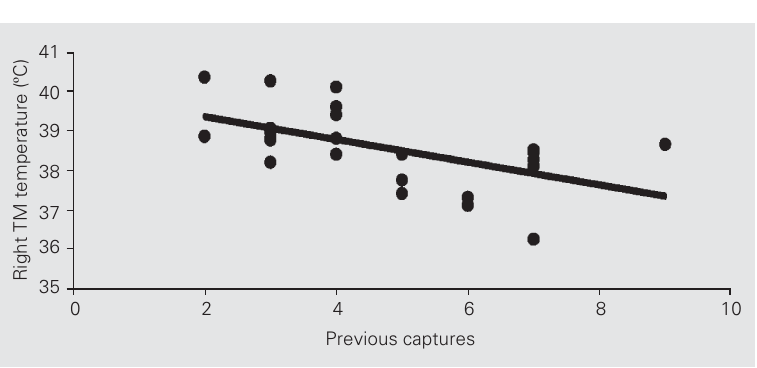
Figure 1. Effect of number of previous captures on tympanic membrane (TM) temperature in the right ear of Callithrix penicillata marmosets during captivity (N = 24). There was a significant negative correlation between the TM temperature of the right ear and the number of previous captures ( r = -0.633; P<0.001; Spearman correlation